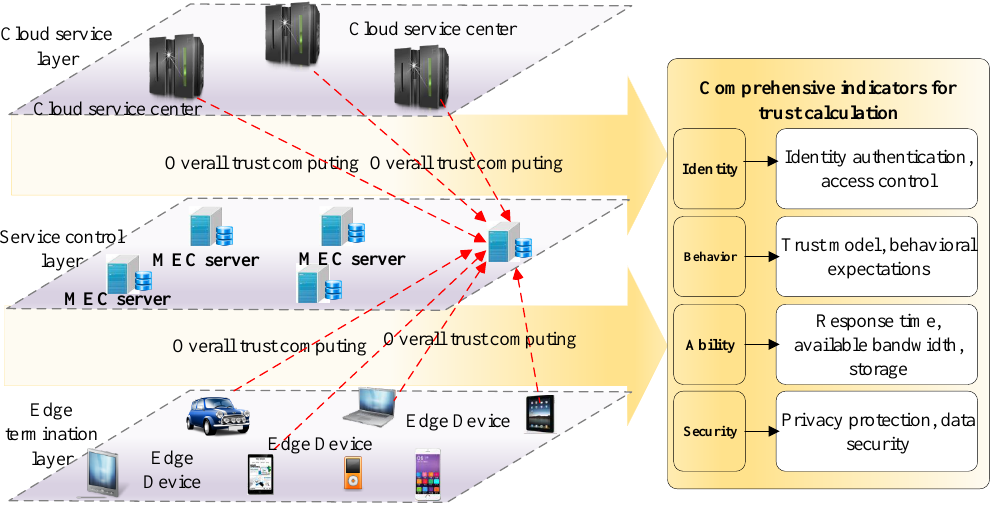
Figure 3. Trusted edge computing network control